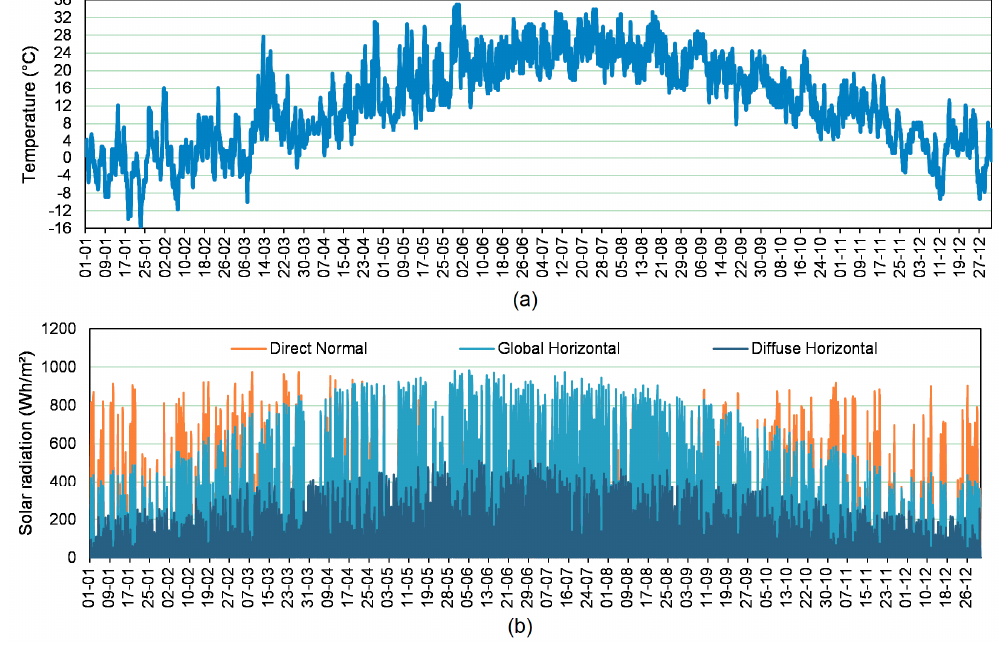
Figure8. Theweatherconditionsforthesimulation. ( a )Outdoorairdry-bulbtemperature;( b Figure 8. The weather conditions for the simulation. ( a ) Outdoor air dry-bulb temperature; ( b ) Solar radiation.